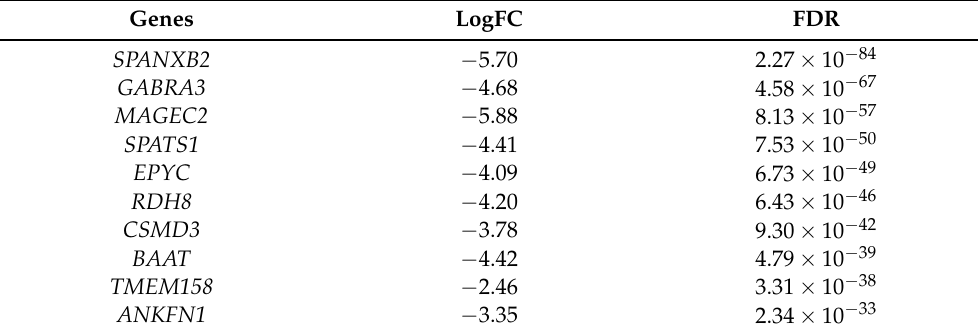
Table 4. List of the ten most significant DEGs found between early (stages I, II and III) and advanced stages (stage IV) from KIRC patients. LogFC—log fold change; FDR—false discovery